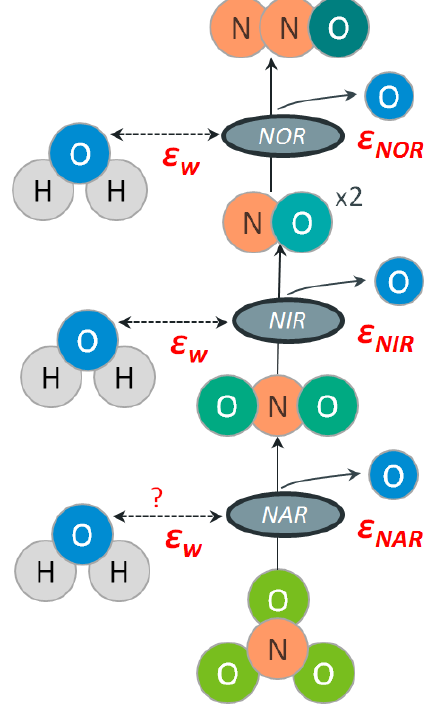
Figure 1. Oxygen isotope fractionation during denitrification as a result of branching effects ( ε NAR ,ε NIR ,ε NOR ) and exchange ef- fects ( ε w ) associated with the following enzymatic reaction steps: NAR, NIR and